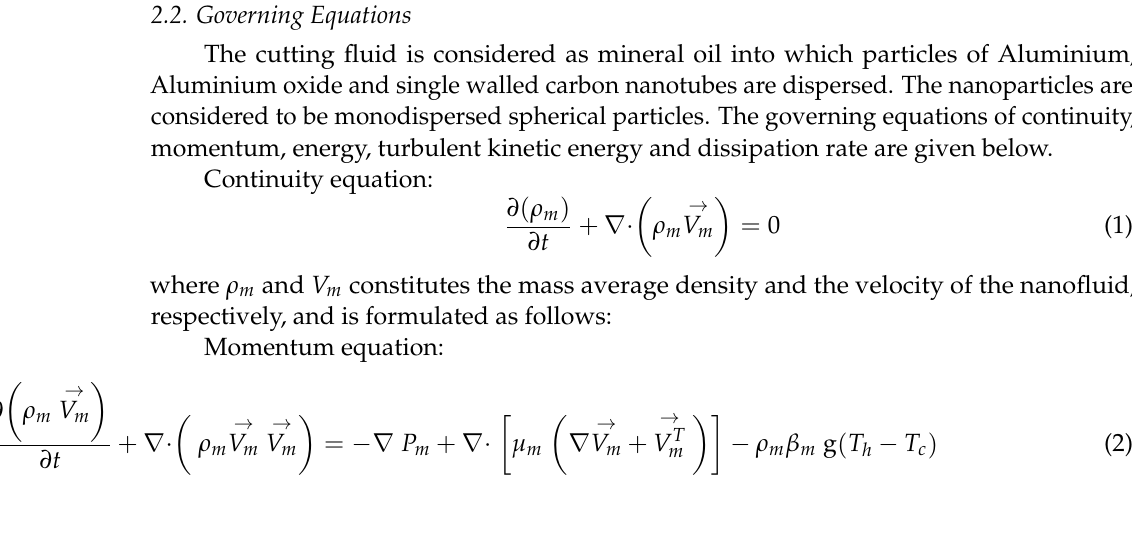
Figure 1. Computational domain comprising of cutting tool, workpiece and nozzle.